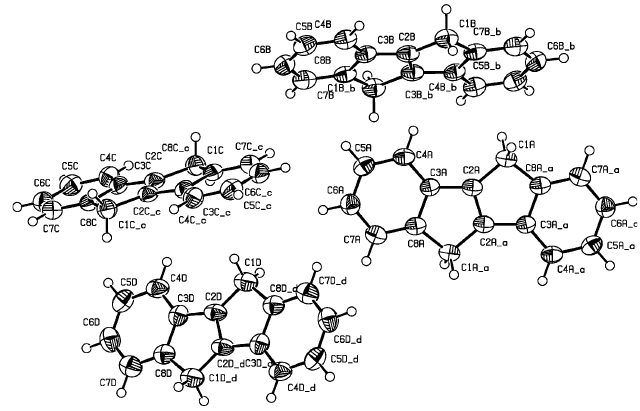
Figure 1 Perspective view of the title compound. Displacement ellipsoids are drawn at the 50% probability level.